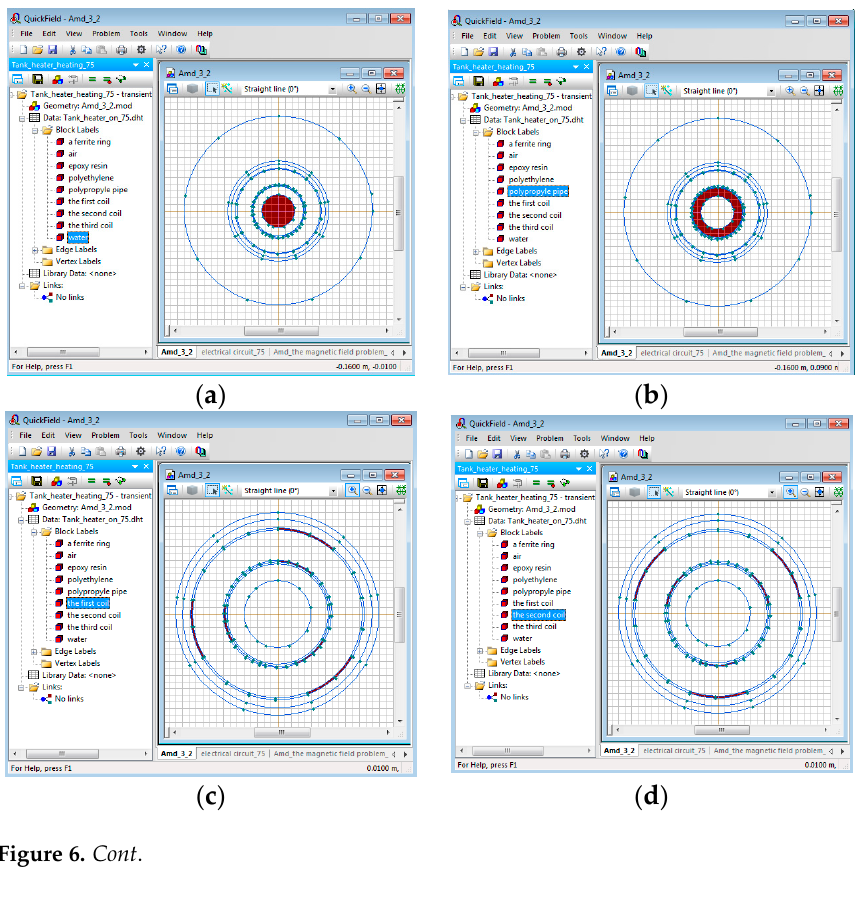
to them. Figure 6 shows the correspondence of each given label to its geometric representation.